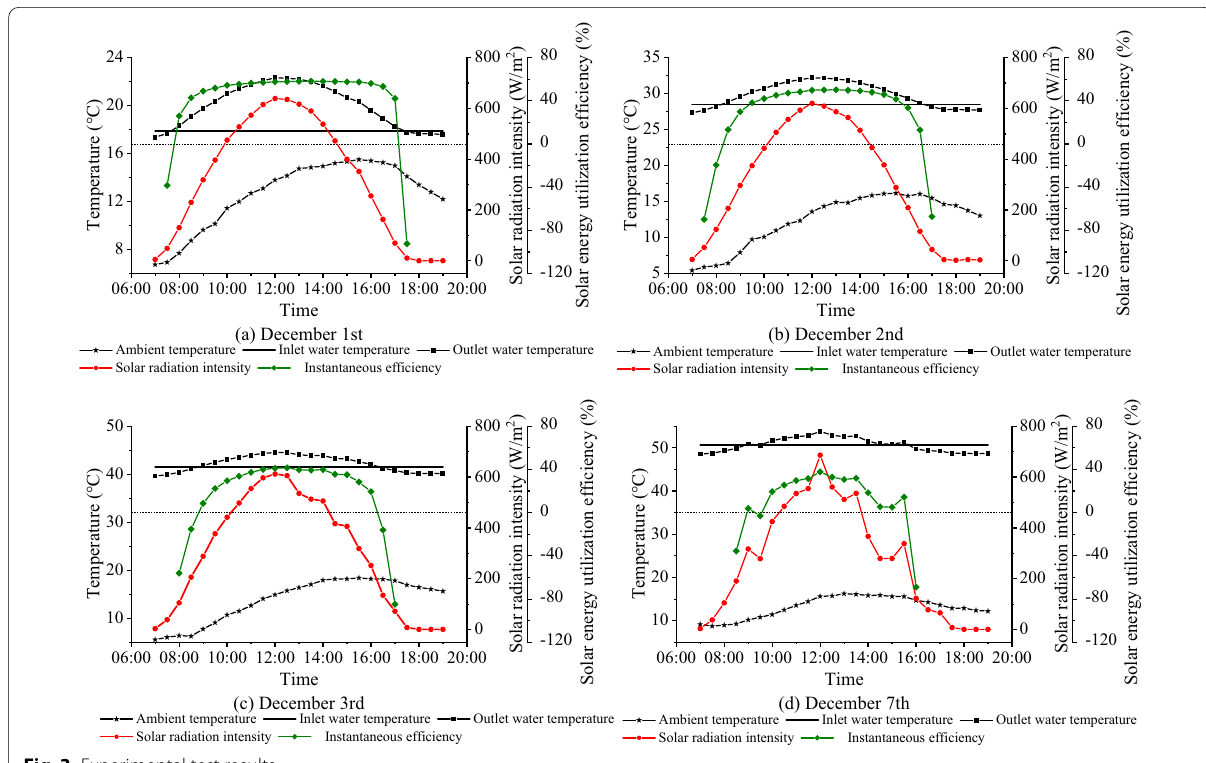
Fig. 3 Experimental test